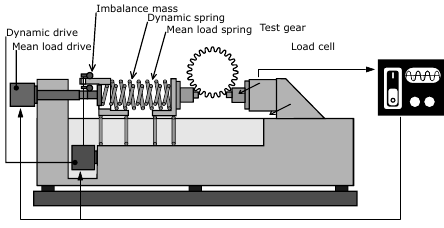
Figure 1. Scheme of the mechanical pulsator.